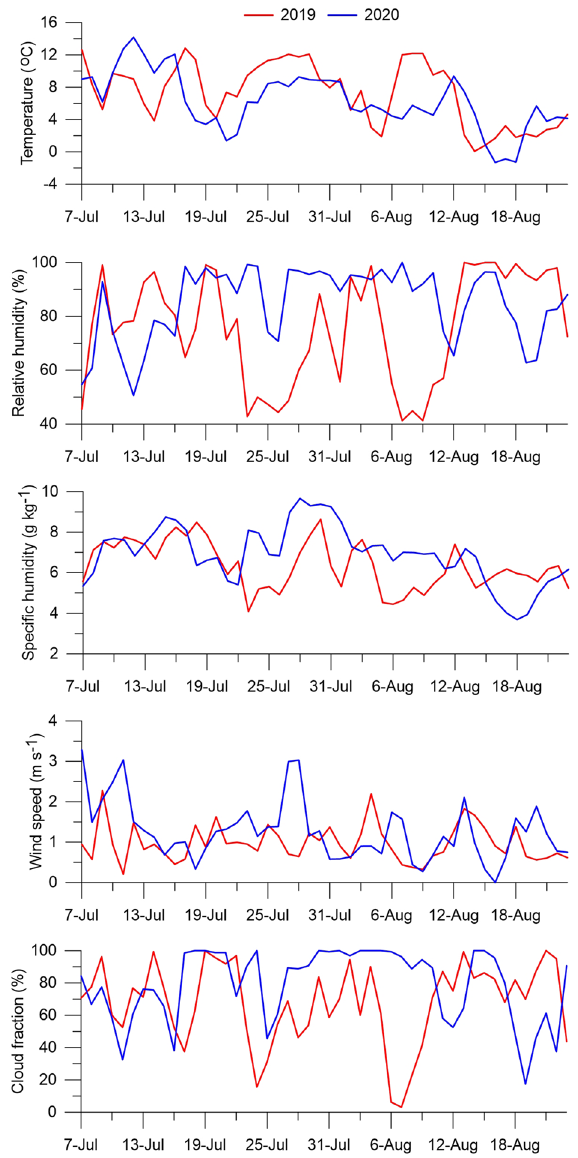
Figure 2. Mean daily values of temperature, relative humidity, and wind speed on the glacier during the 2019 and 2020 ablation seasons (for the period 7 July to 23 August). Cloudiness data were obtained at the Chara weather